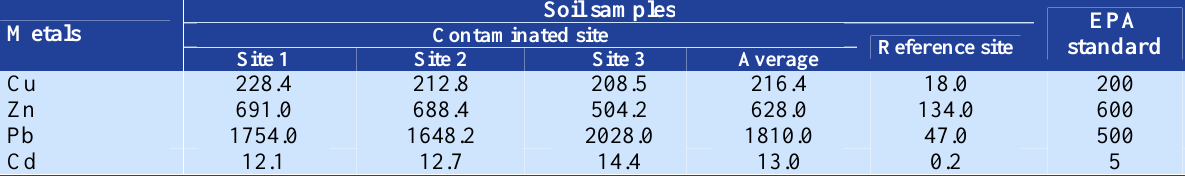
Table 3. Heavy metals concentrations in soil (mg/kg)